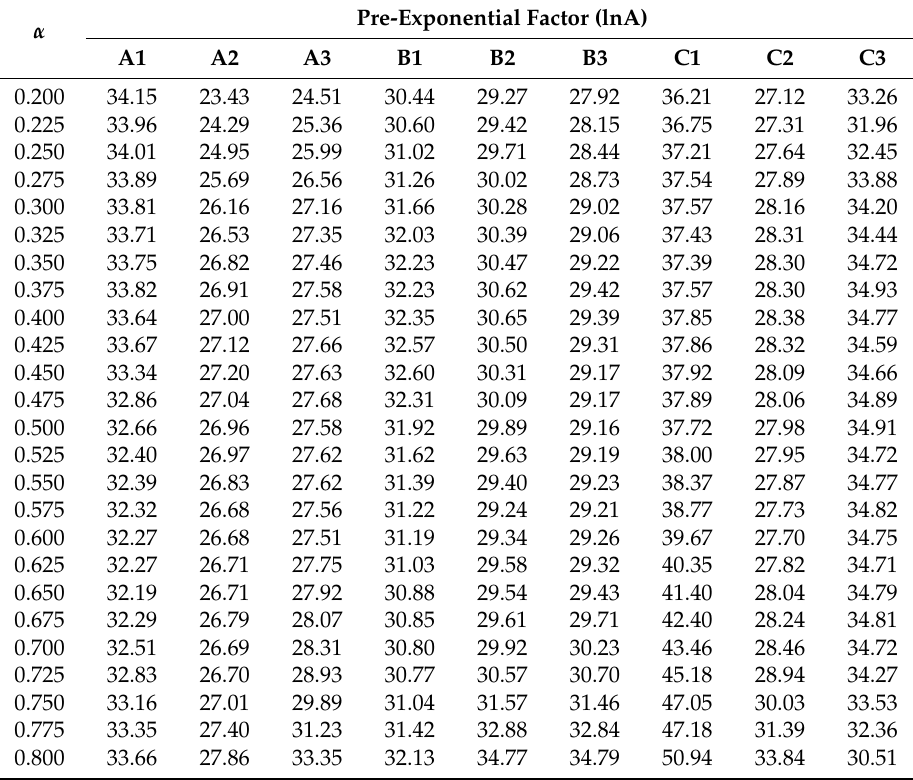
Table 3. Pre-exponential factor of all the materials.